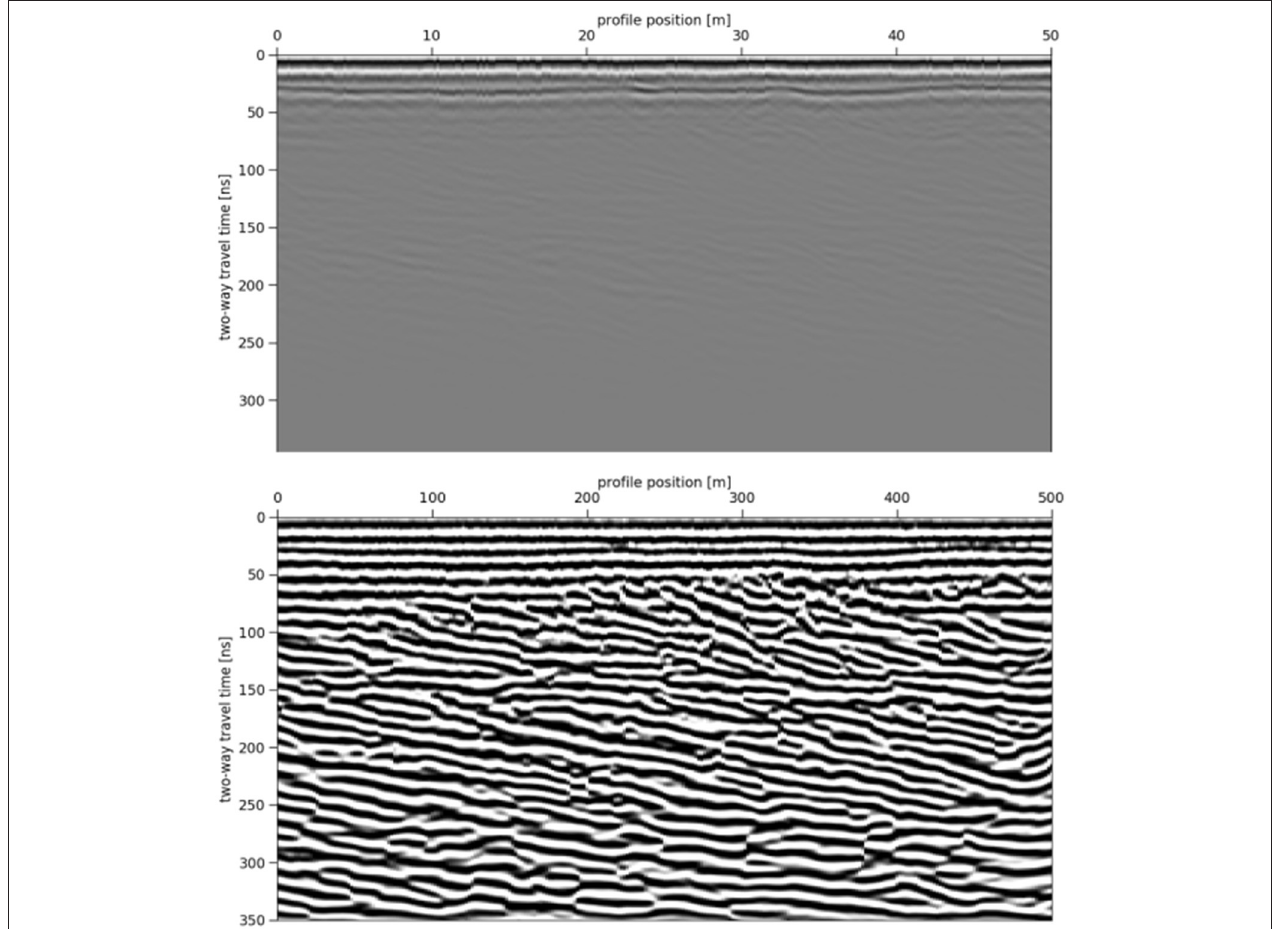
FIGURE 2 | Profile A radargrams loaded in GPRPy. (Upper) edited raw data. (Lower) final processed